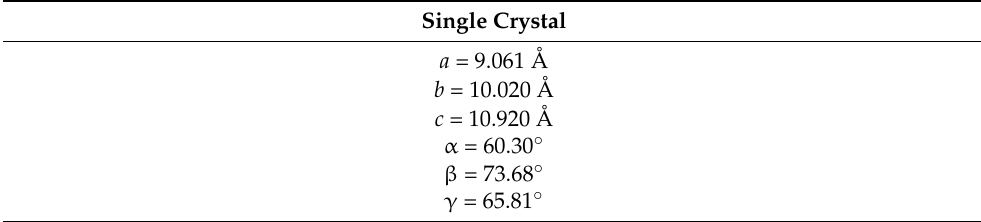
Table 6. Main parameters of the crystal structure of SFCA [17] (ICDD: